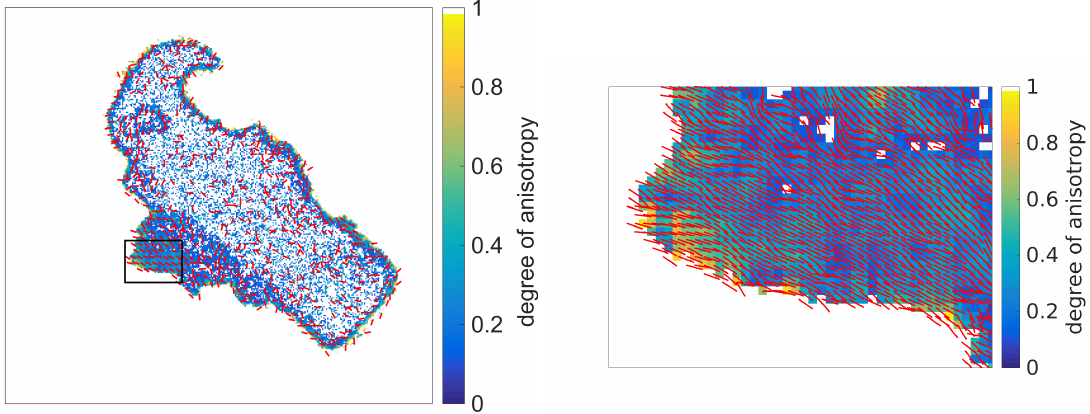
Figure 11. Reconstruction of fibre orientations ( left ) caused by the mineralised textile structures at the pin of the bird fibula (photography in Figure 4). A zoom on the region in the left figure marked with a black rectangle is shown ( right ). The red lines point in the main direction of aligned structures and are plotted on the colour-coded degree of